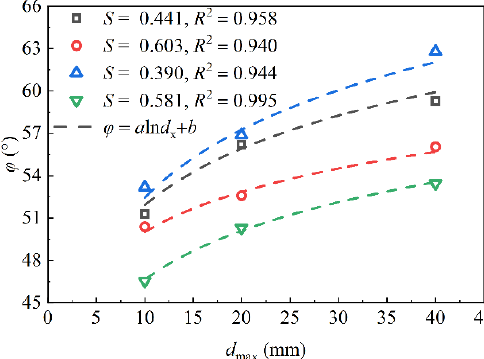
Figure 8. Relationship between internal maximum particle size and cohesion of test CGS.